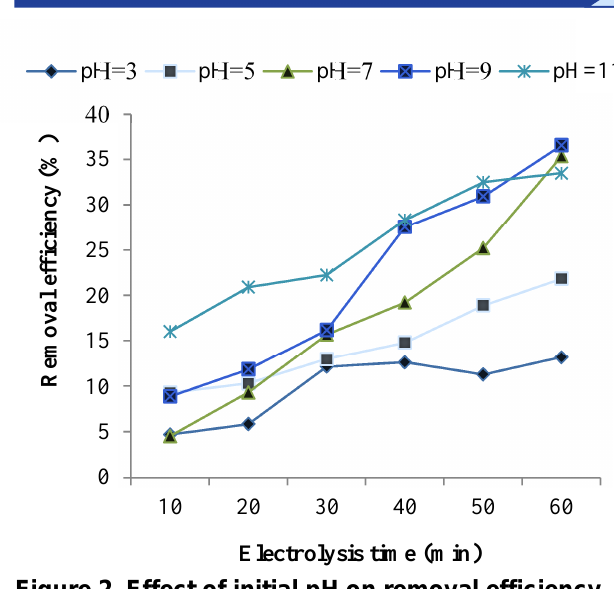
Figure 2. Effect of initial pH on removal efficiency of Reactive Green 19 (RG-19) dye (Voltage = 10 v, C 0 = 50 mg/l, d = 1 cm, KCl = 0.005 M, T = 22 ± 2 º C)